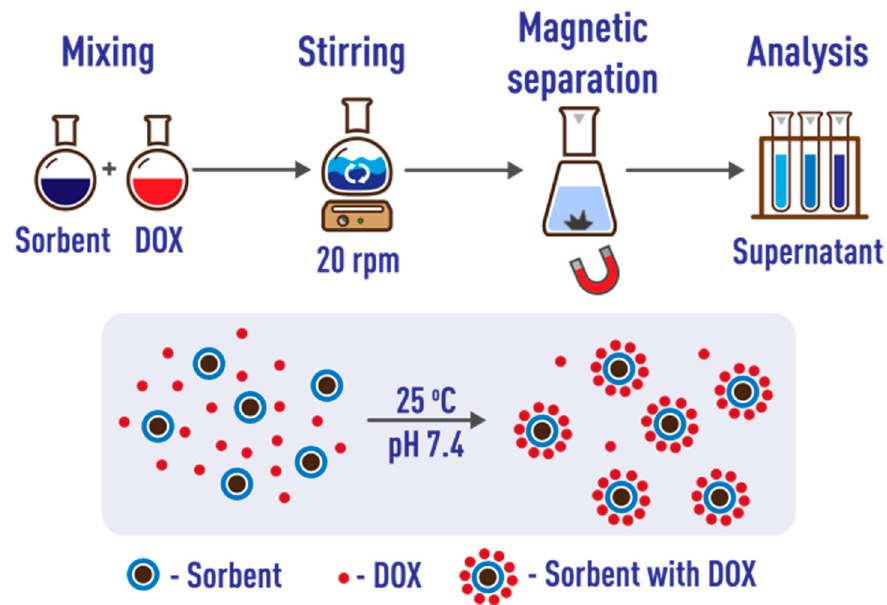
Figure 13. Exploring doxorubicin sorption on modified IONs. DOX = doxorubicin.